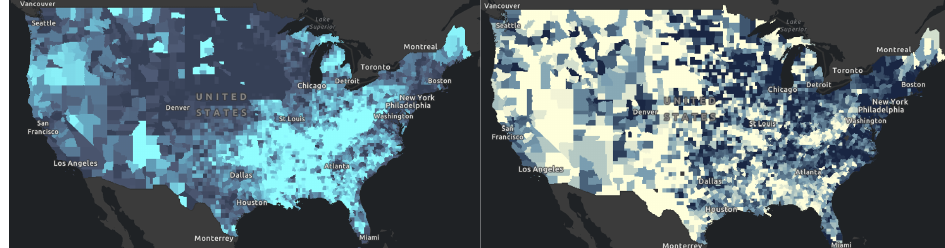
Figure 7. ( Left ) Geographic distribution of percentage of adults reporting 14 or more days of poor mental health per month (lighter colors represent higher percentages). ( Right ) The shade of color in the map corresponds to the value designated in the colored shading in the figure above. Percentage of flu vaccinations are on the right (darker colors represent higher percentages).